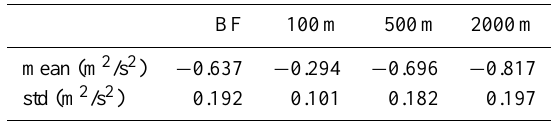
Fig. 8. Mean winter buoyancy fluxes (black) over time (years in- dicated are the ones in which the winter starts), B t (red) and B s (green). The blue line shows the average winter buoyancy fluxes while the dashed blue lines show the mean plus or minus a standard deviation.